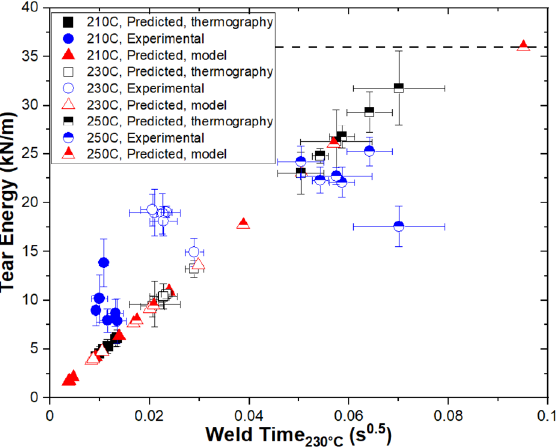
Figure 6. Validation of the model based on tear energy as a function of the square root of isothermal weld time at 230 °C. Tear energies reported include experimental values (blue circles), values predicted from thermography (black squares), and values predicted by the base model (red triangles). Experimental results and thermography data used for prediction are from Ref. 17 . Error bars represent one standard deviation.